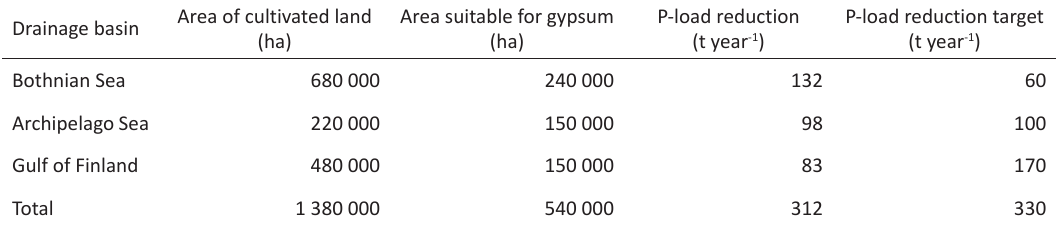
Table 4. Total area of cultivated land, area suitable for gypsum amendment, annual reduction in phosphorus loads and annual phosphorus load reduction target in three drainage basins in Finland Drainage